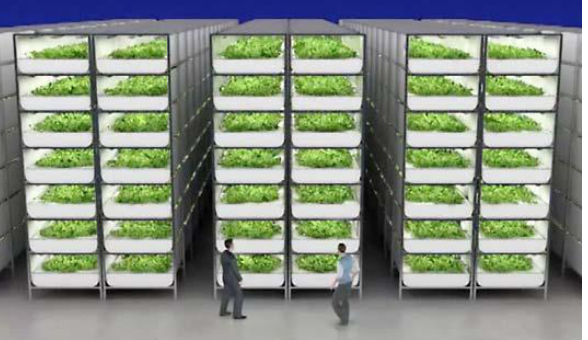
Figure 1. The vertical agriculture growing in several layers and less space [2].